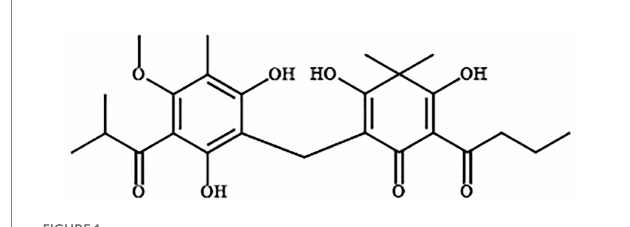
FIGURE 1 Structures of Disaspidin BB (Zheng et al.,